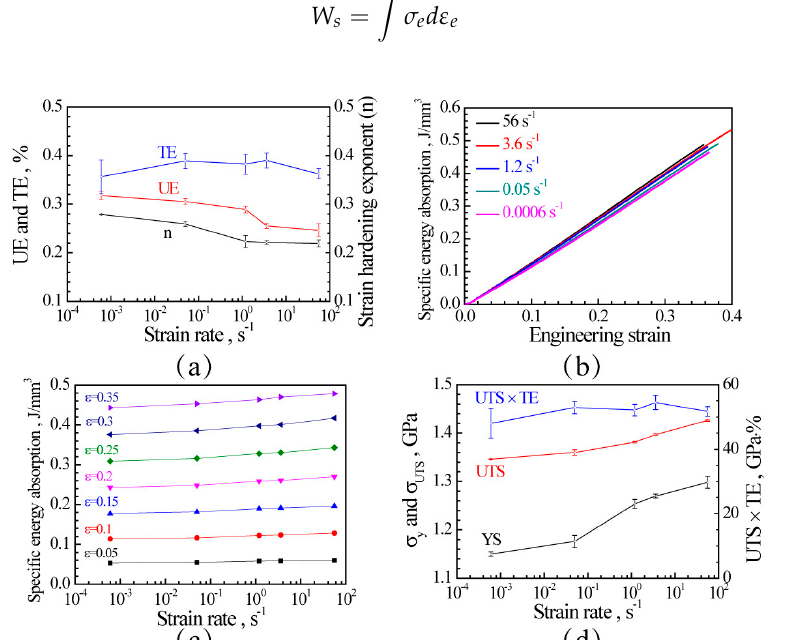
Figure 4. ( a ) Uniform elongation, total elongation and strain hardening exponent as a function of strain rate for the HSSS; ( b ) Specific energy absorption as a function of engineering strain at various strain rates; ( c ) Specific energy absorption as a function of strain rate at various engineering strains; ( d ) Yield strength, ultimate strength and tensile toughness as a function of strain rate.